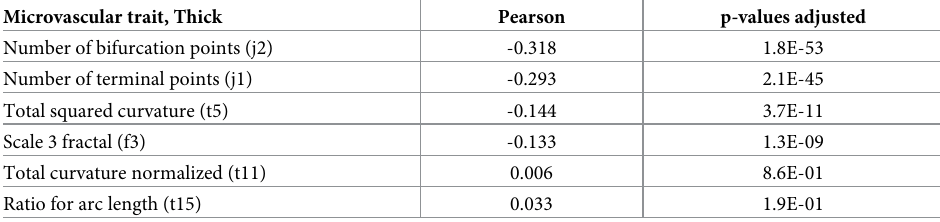
The four most correlated traits shown in Fig 1A and 1B and two traits unaffected by age. The full names for tortuosity traits: total squared curvature (t5), total curvature divided over the chord length (t11), and interpolated arc length divided by original arc length (t15). Gender: males and females combined.